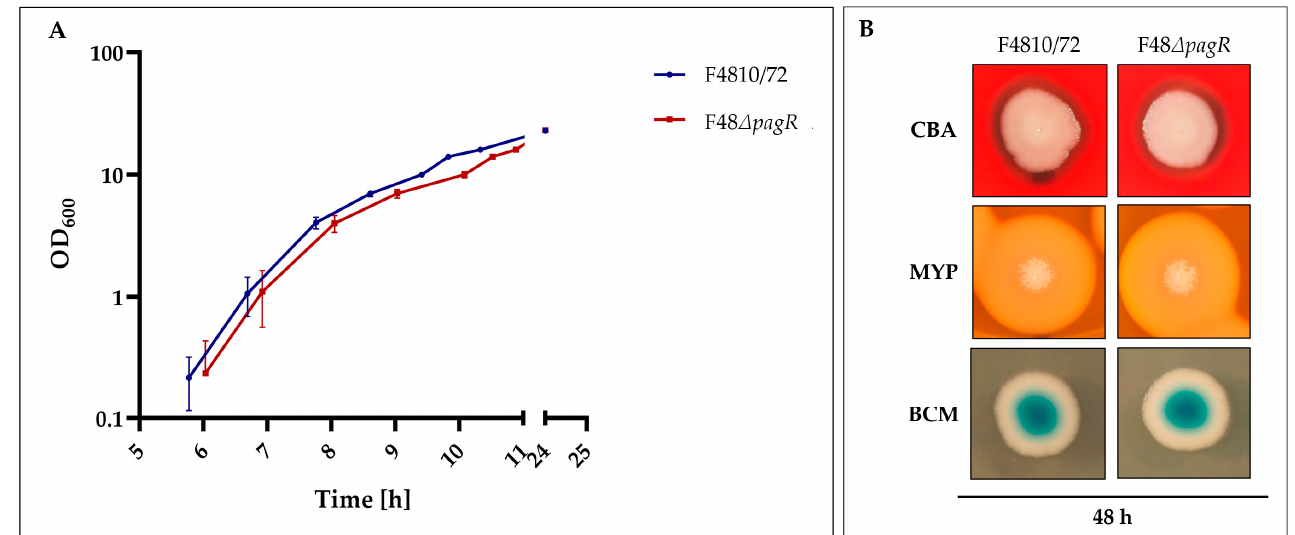
Figure 5. Growth and colony phenotypes of emetic B. cereus F4810/72 and its isogenic F48 ∆ pagR mutant. ( A ): Growth curves of wild-type and F48 ∆ pagR mutant. Strains were cultivated in LB broth at 30 ◦ C. The growth was monitored by measuring the optical density at 600 nm (OD 600 ), shown are averages with standard deviations from three independent experiments. ( B ): Strains were grown on Columbia blood agar (CBA), Mannitol egg yolk polymyxin agar (MYP) and Brilliance Bacillus cereus agar (BCM), incubated at 30 ◦ C for 48 h.